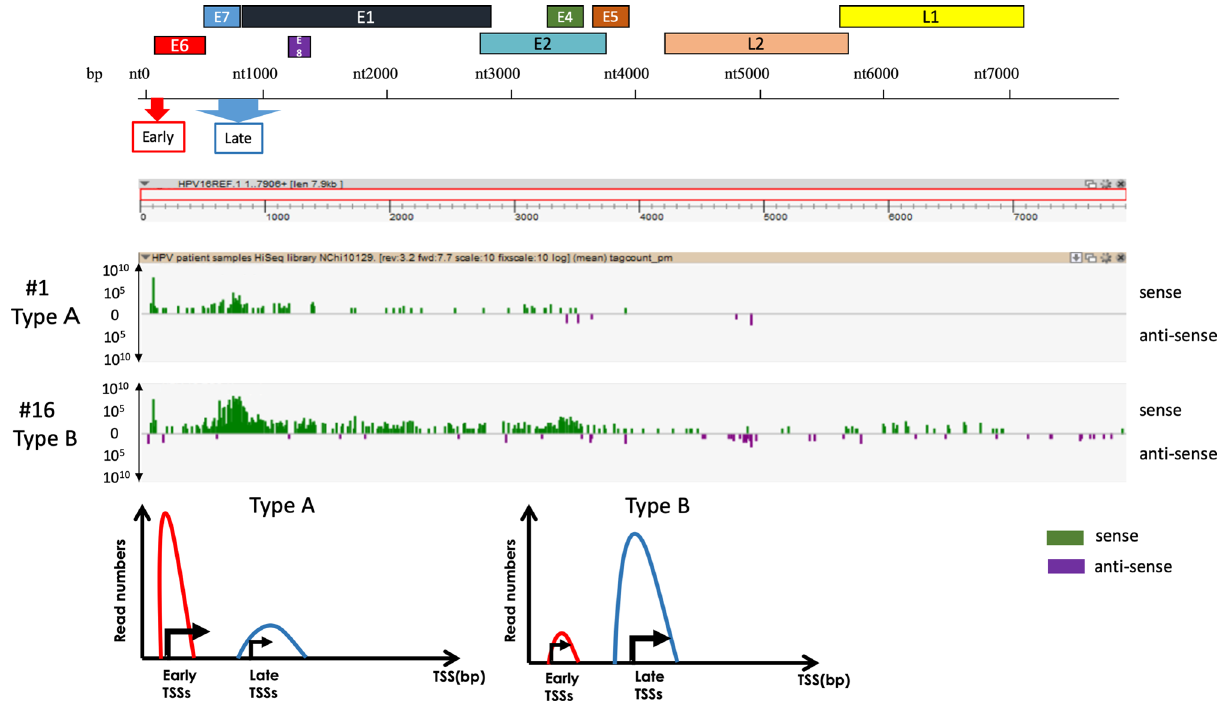
Figure 1. nAnTi-CAGE and nanoCAGE TSSs of HPV-positive cervical lesions. Forty-six cervical lesions, representing both normal and cancerous lesions, were analysed by nAnTi-CAGE or nanoCAGE (9 for nAnTi- CAGE and 39 for nanoCAGE). The HPV TSS patterns were investigated and classified by the prominent TSS types. Regardless of the HPV type, early and late promoter activity was defined by the numbers of TSSs in each transcriptome that started either between nucleotides 80 and 110, or between nucleotides 600 and 950. The TSS patterns were defined as follows: Type A, one-third of early promoter activity ≥ late promoter activity; Type B, one-third of early promoter activity < late promoter activity. To visualise TSS levels at the single-nucleotide level, nanoCAGE data were visualised using ZENBU software. Representative data for each TSS pattern are shown. TSS transcription start site.